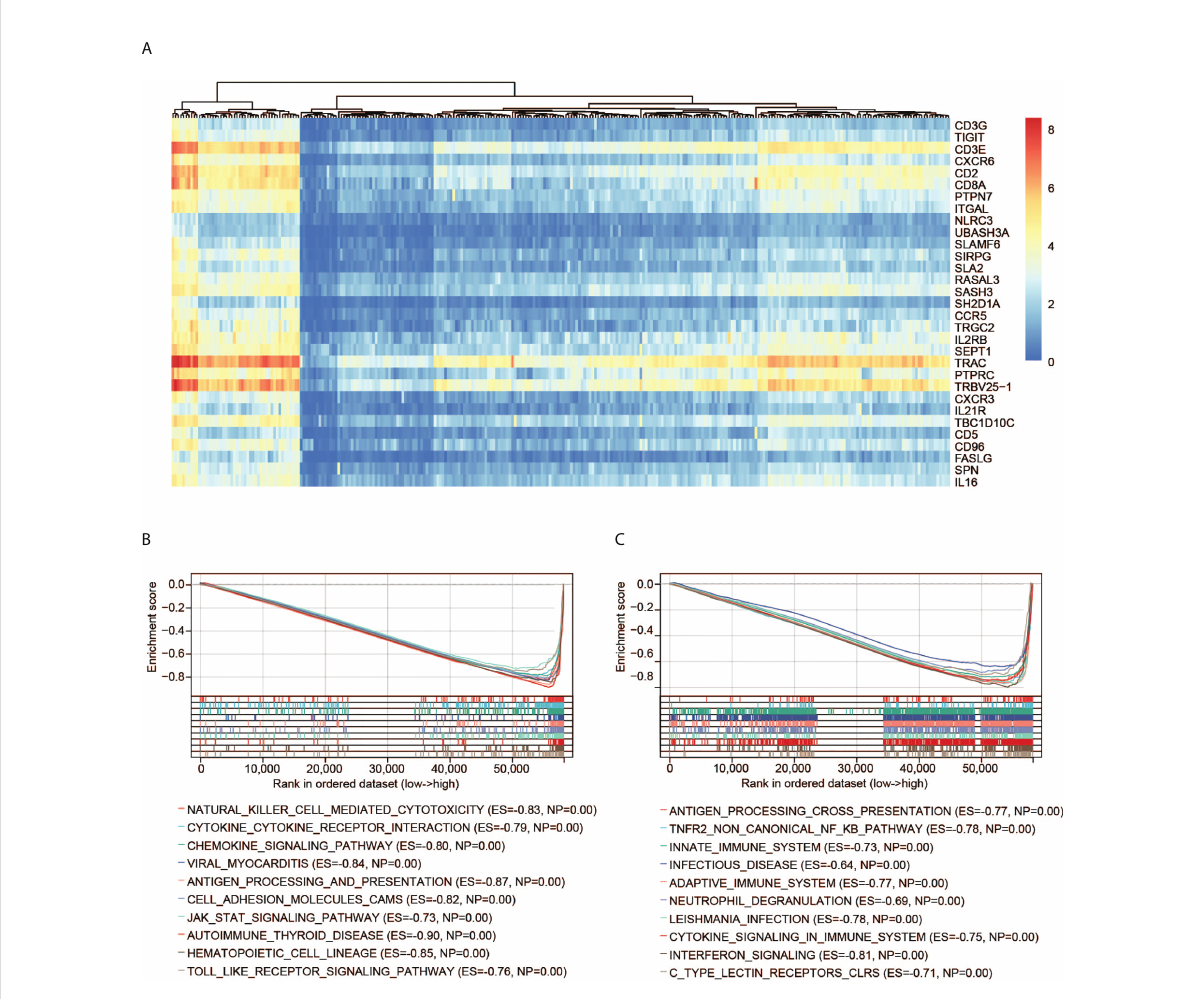
FIGURE 6 GSEA of CD3G. (A) The expression pro fi les of the top 30 genes contributing to core enrichment. (B) The top 10 signi fi cant KEGG pathways associated with high CD3G expression. (C) The top 10 signi fi cant Reactome pathways associated with high CD3G